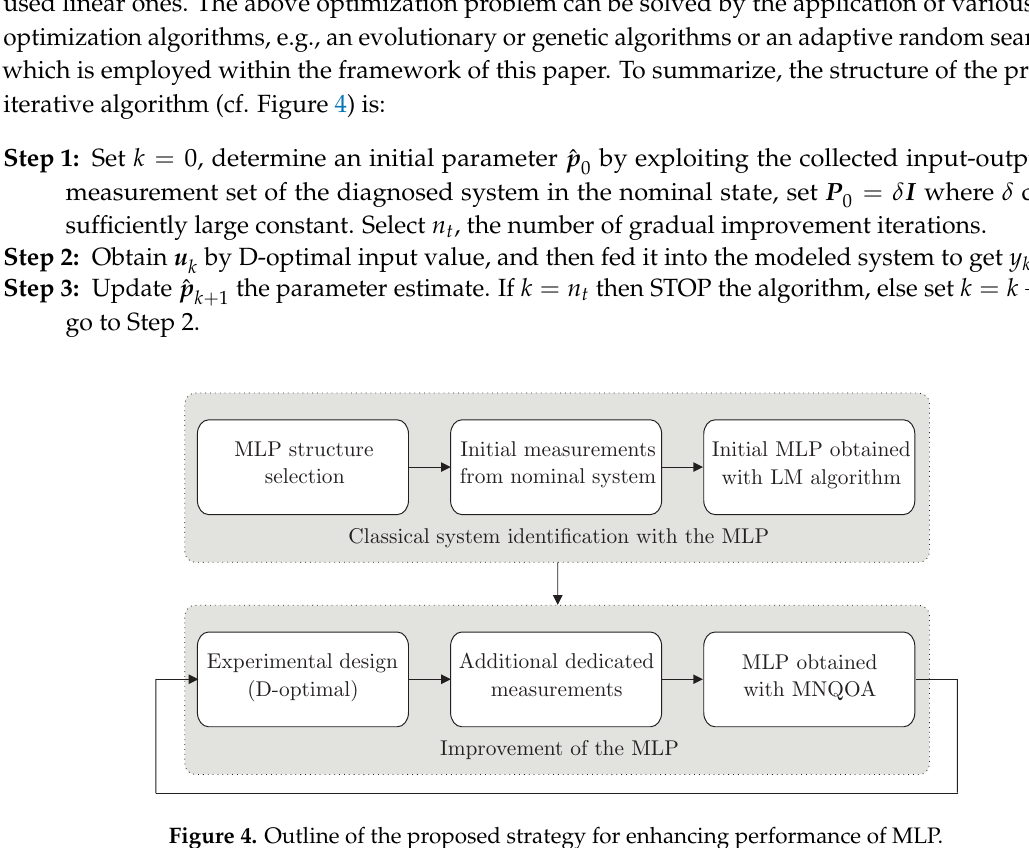
Figure 4. Outline of the proposed strategy for enhancing performance of